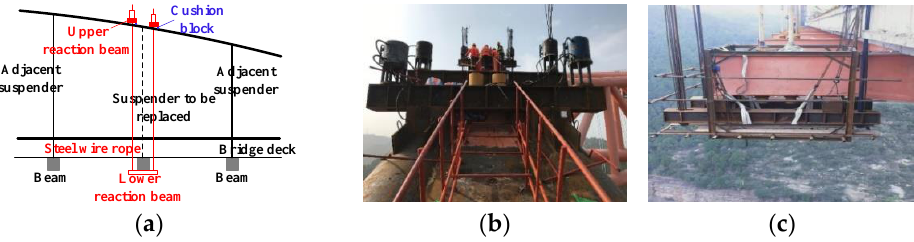
Figure 4. Suspender replacement construction process. ( a ) Schematic of the replacement scheme, ( b ) Upper construction and ( c ) Lower construction.